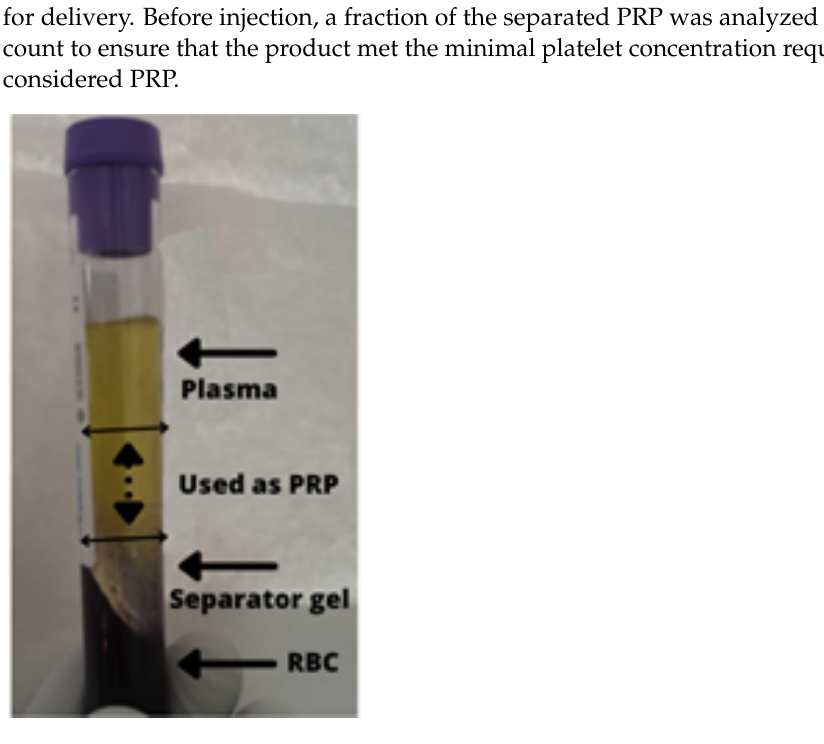
Figure 2. Suspended laryngoscopy with vocal fold cyst excision: ( A ) preoperative image of right vocal fold cyst and ( B ) postoperative image after hemostasis was obtained. The site of the injection is marked with an arrow. 2.8. Statistical Analysis